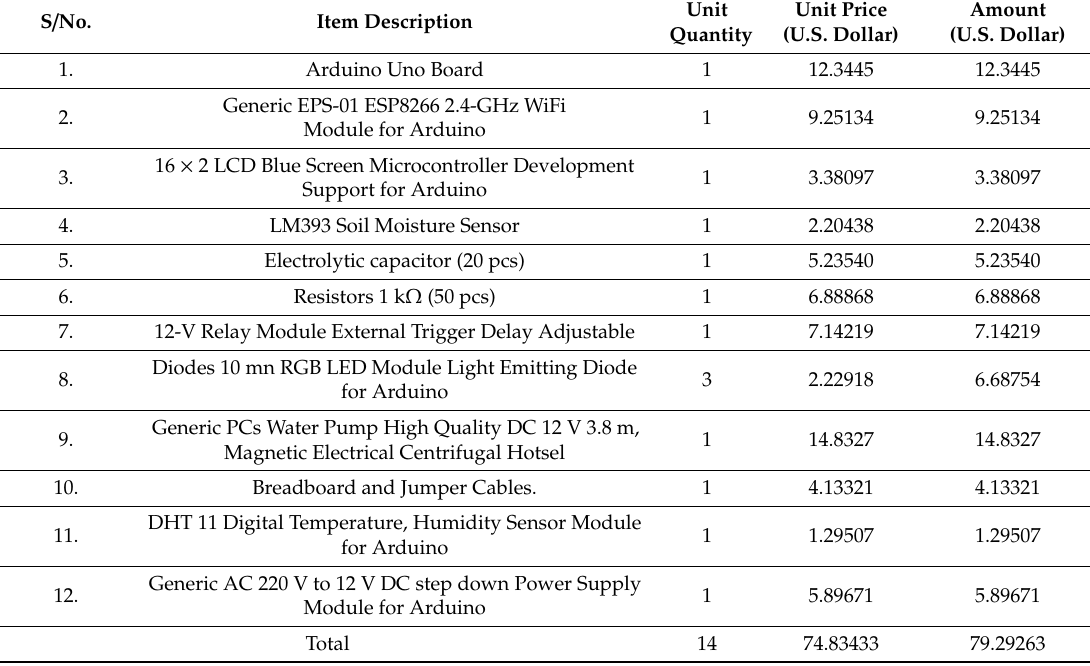
Table 1. Cost analysis of the implemented device prototype.